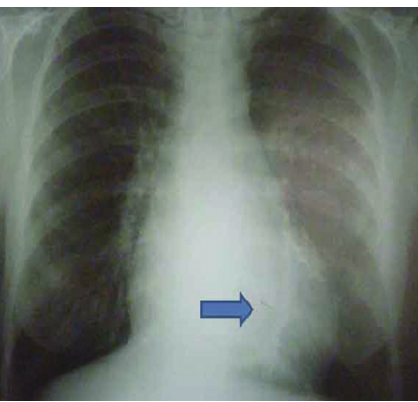
Figure 1: Oblique linear calcification (thick arrow) in chest X-ray.